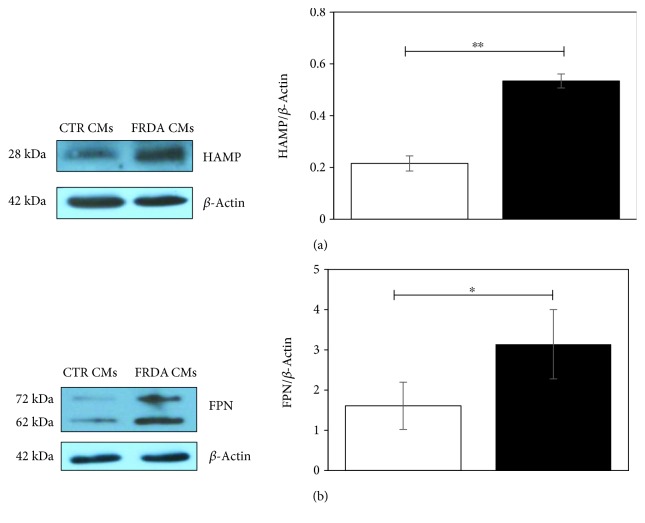
Protein expression of HAMP and FPN. (a) A representative Western blot image of HAMP expression. The band densities were analyzed by densitometry and normalized to β-actin. Histogram showing means ± Std Dev of HAMP/β-actin. (b) A representative Western blot image of FPN expression. The band densities were analyzed by densitometry and normalized to β-actin. Histogram showing means ± Std Dev of FPN/β-actin. Data are from three independent differentiation experiments. ∗
p < 0.05; ∗∗
p < 0.01.